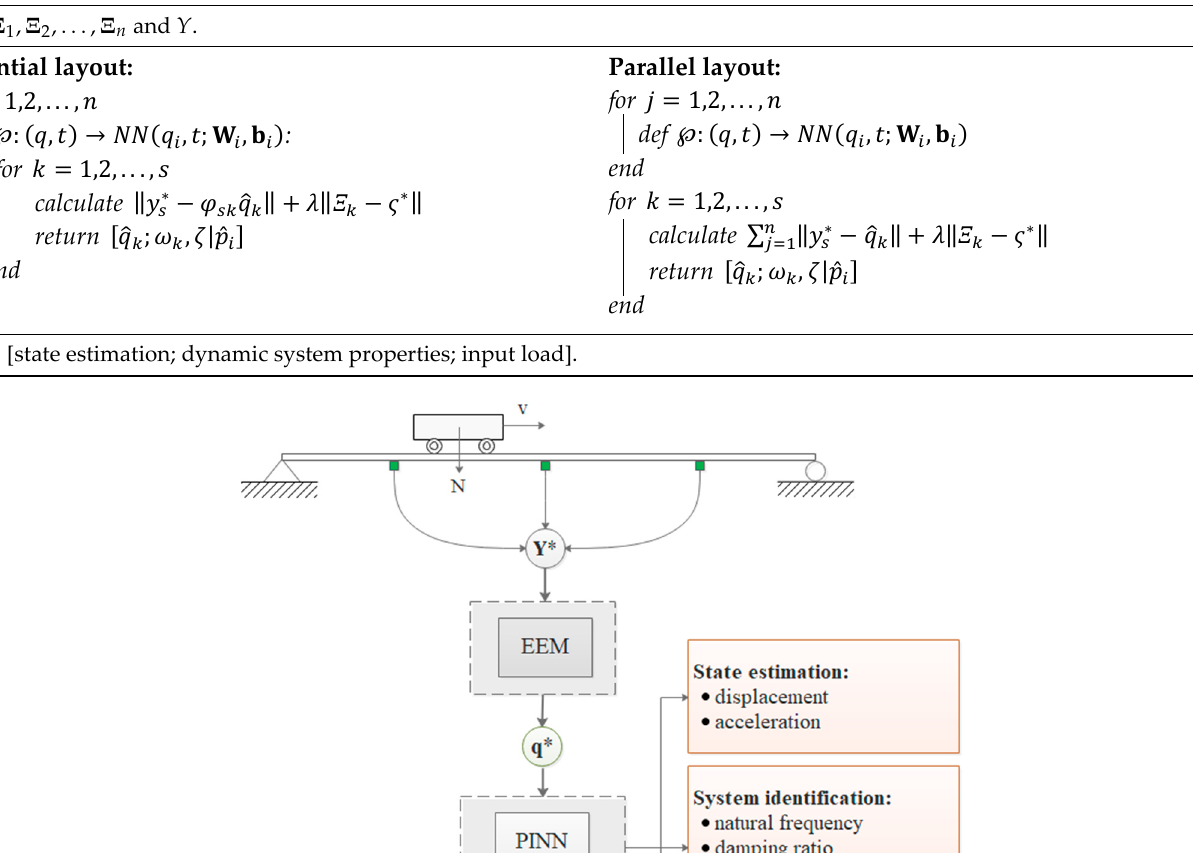
Figure 4. Input and outputs of a PINN framework for a beam subjected to moving load. Algorithm 1 Proposed framewoark with sequential and parallel PINNs. Algorithm 1 Proposed framewoark with sequential and parallel PINNs.